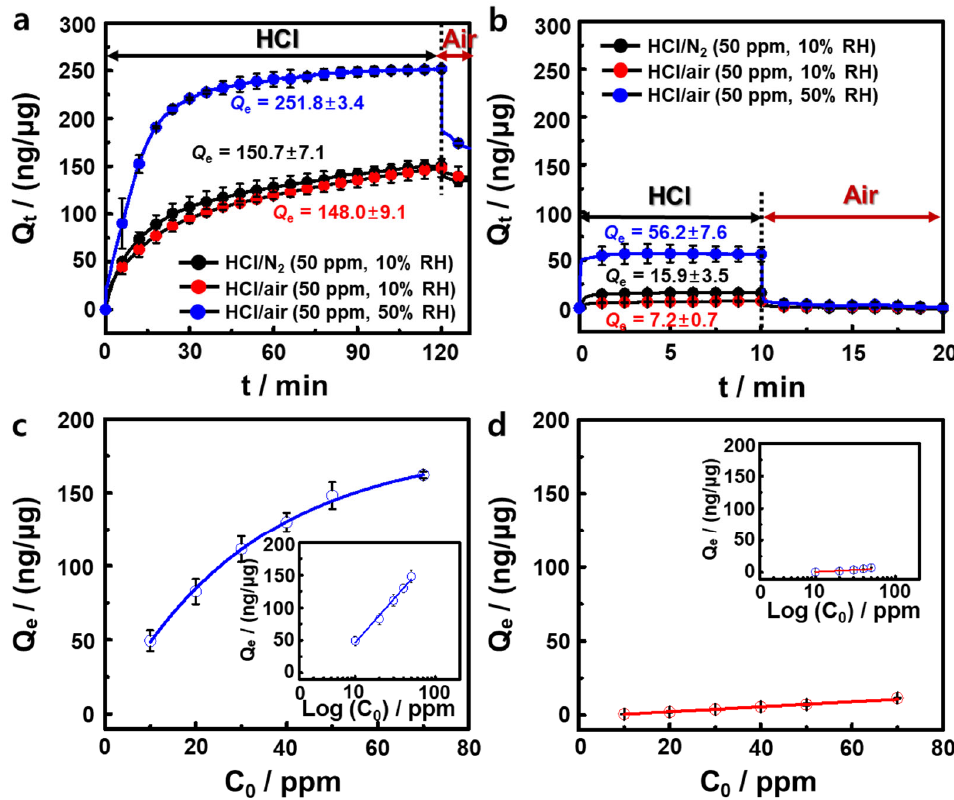
Figure 4. ( a , b ) Binding capacity ( Q t ) as a function of time for ( a ) poly(DMAEMA-co-EGDMA) and ( b ) poly(DMAA-co-EGDMA) films in 50-ppm HCl with various carrier gases, i.e., dried N 2 (10%